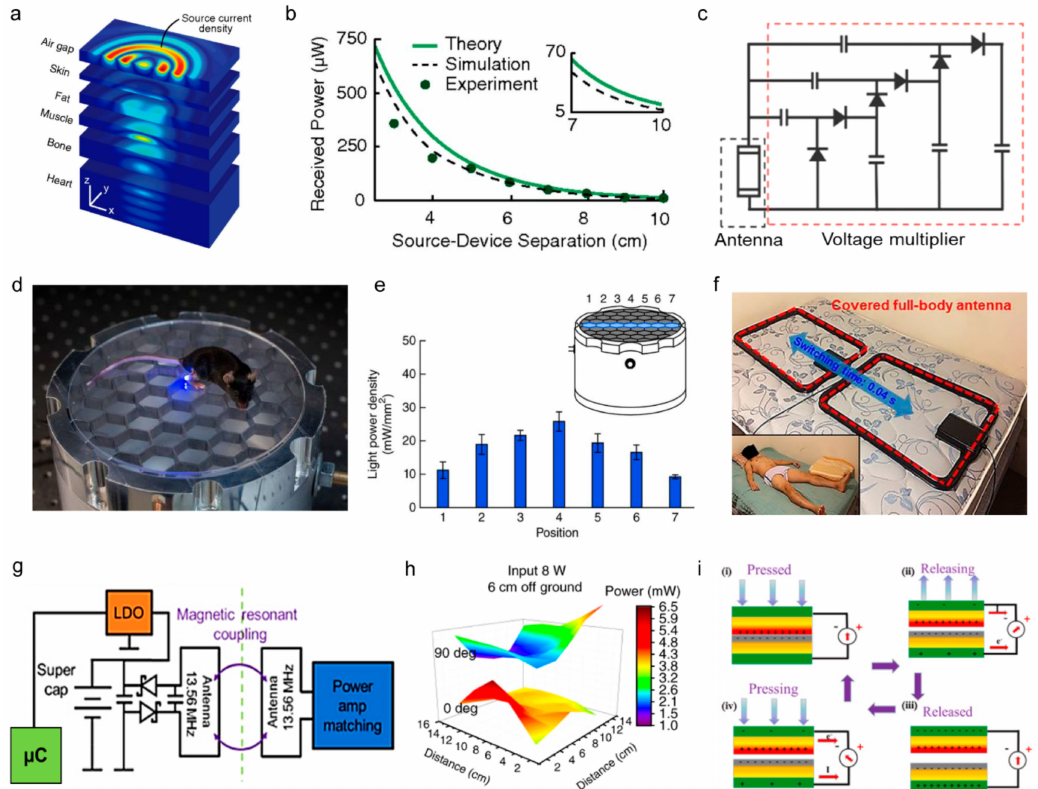
Figure 2. Wireless power supply technologies for wearable sensors. ( a ) Expanded view of the magnetic field in tissue multilayers, revealing propagating waves that converge on the coil